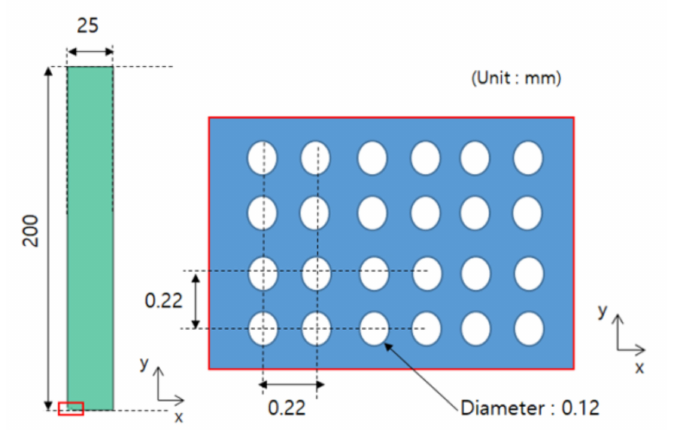
Figure 5. Dimension and distribution of circular pores (Reprinted from Ref. [13]).